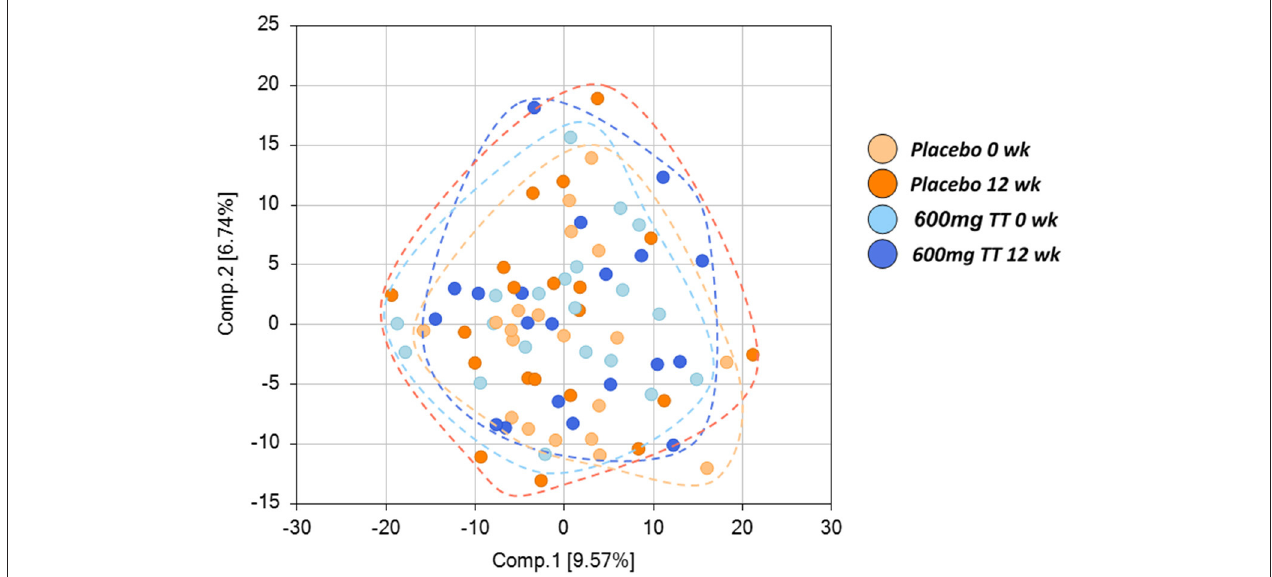
FIGURE 1 | Score plot of principle component analysis (PCA) of the Placebo and the High TT groups at 0 and 12 wk. Placebo at 0 wk (light orange), Placebo at 12 wk (dark orange), 600mg TT at 0 wk (light blue), 600mg TT at 12 wk (dark blue). Principal component analysis (PCA) showed no differences in serum metabolites between the Placebo and the 600mg TT group, as demonstrated by the lack of separation between the Placebo and the 600mg TT group. Each ball represents the cumulative metabolites from each participant. The 20 light orange balls are from Placebo group at 0 wk, 20 orange balls are from Placebo group at 12 wk, 20 light blue balls are from 600mg TT group at 0 wk, and 20 dark blue balls are from 600mg TT group at 12